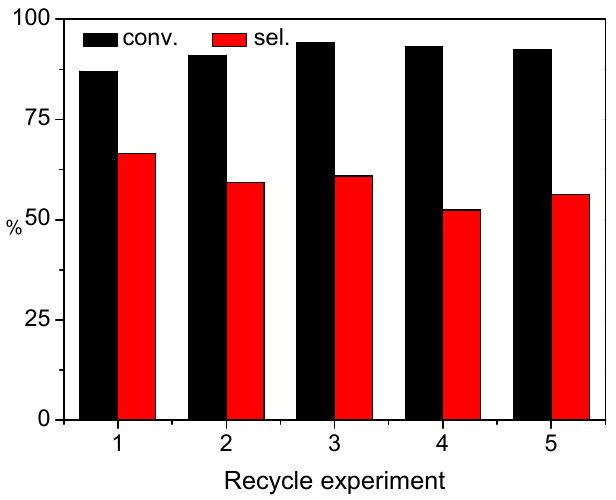
Figure 9. Reusability of the Pt8Co1/ZSM-5-AT catalyst toward the selective hydrogenation of CAL. Reaction conditions: 200 mg of catalyst, 4 mmol of CAL, P H2 = 2 MPa, 20 mL of ethanol, at 100 °C, for 2 h, with a stirring rate of 1000 rpm.